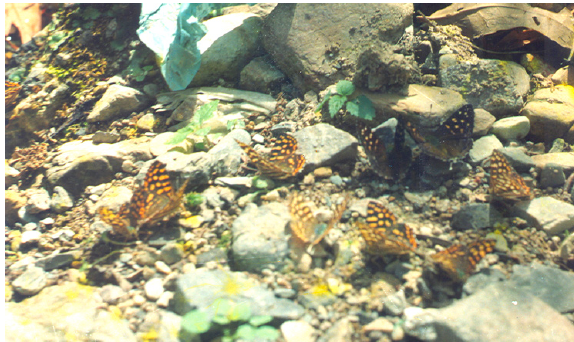
Image 3. Butterflies mud-puddling site close to Bhilaru Pumping Station spring,